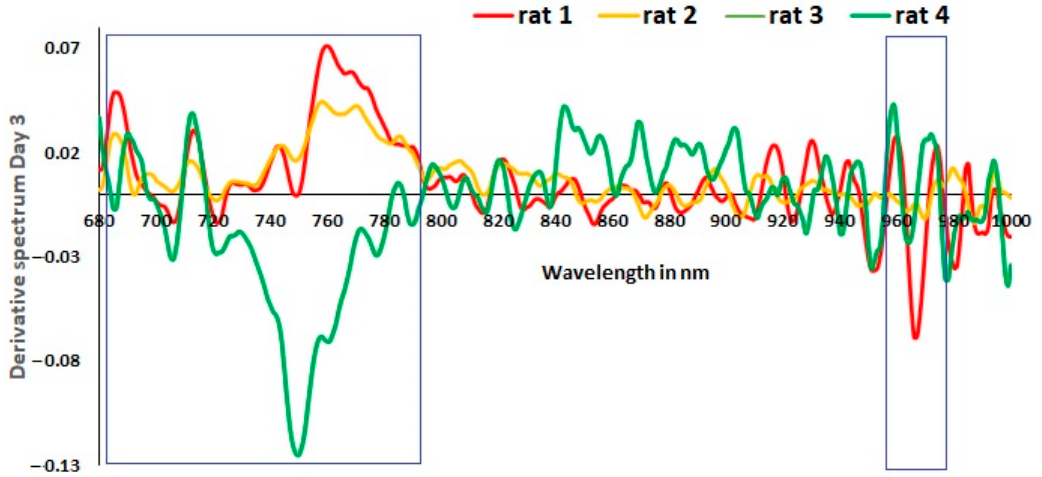
Figure 5. In vivo results. Derivative spectra plotted from one measurement of day 3. It is plotted for all four rats. Rat 3 and rat 4 overlap 100%. Rat 1 and rat 2 are significantly different from rats 3 and 4. Later that same day, rat 1 died. This rat showed two predominant peaks that stand out from the normal rats (rat3 and rat4), one at 965–975 nm and the other at 680–800 nm. The one at 965–975 nm and the other at 680–800 nm correspond to water absorption and hemoglobin.